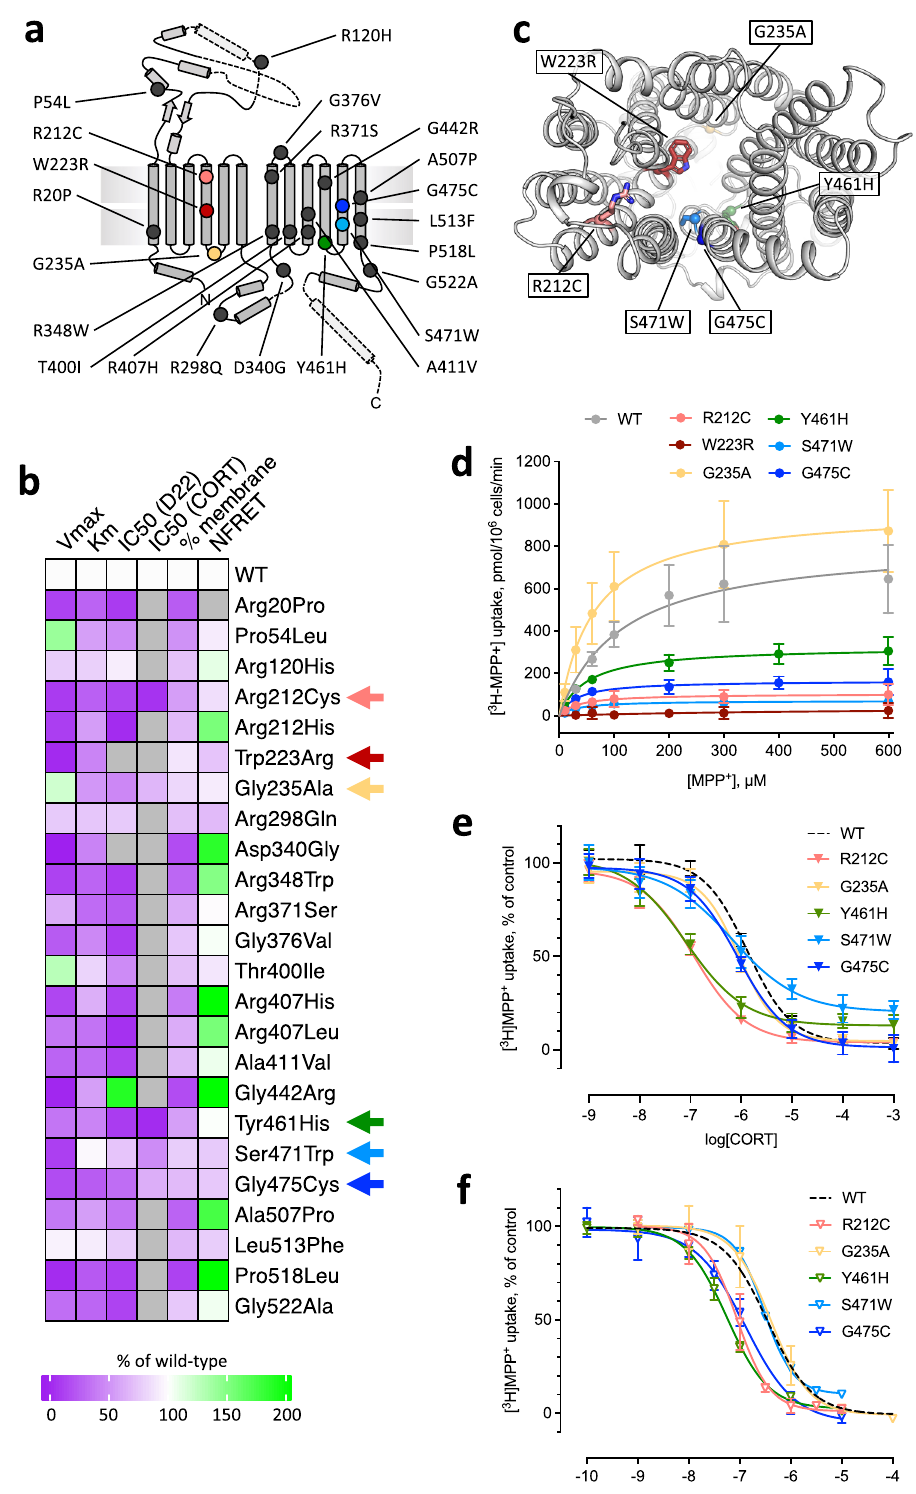
Fig. 4 | Functional analysis of OCT3 mutants. a Distribution of the OCT3 genetic variants, mappedon the structure ofOCT3. b A heatmapillustrating the effectsof mutations. The scale bar indicates the increase (green) or decrease (magenta) of V max , K m , IC 50 , membrane expression and NFRET compared to wild-type, as detailed in Materials and Methods. Arrows indicate the variants selected for detailed characterization. c View of OCT3 from the extracellular space, with the